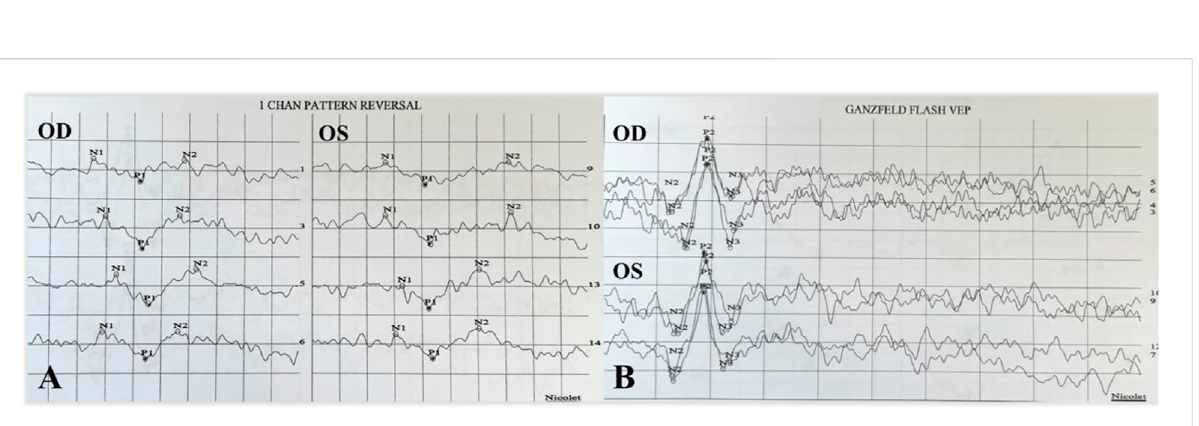
FIGURE 7 P-VEP and F-VEP of proband ’ s mother. The latency of the waveform recorded by P-VEP was delayed and decreased slightly at high SF in both eyes (A) . The amplitude of the waveform recorded by F-VEP was normal in both eyes (B)